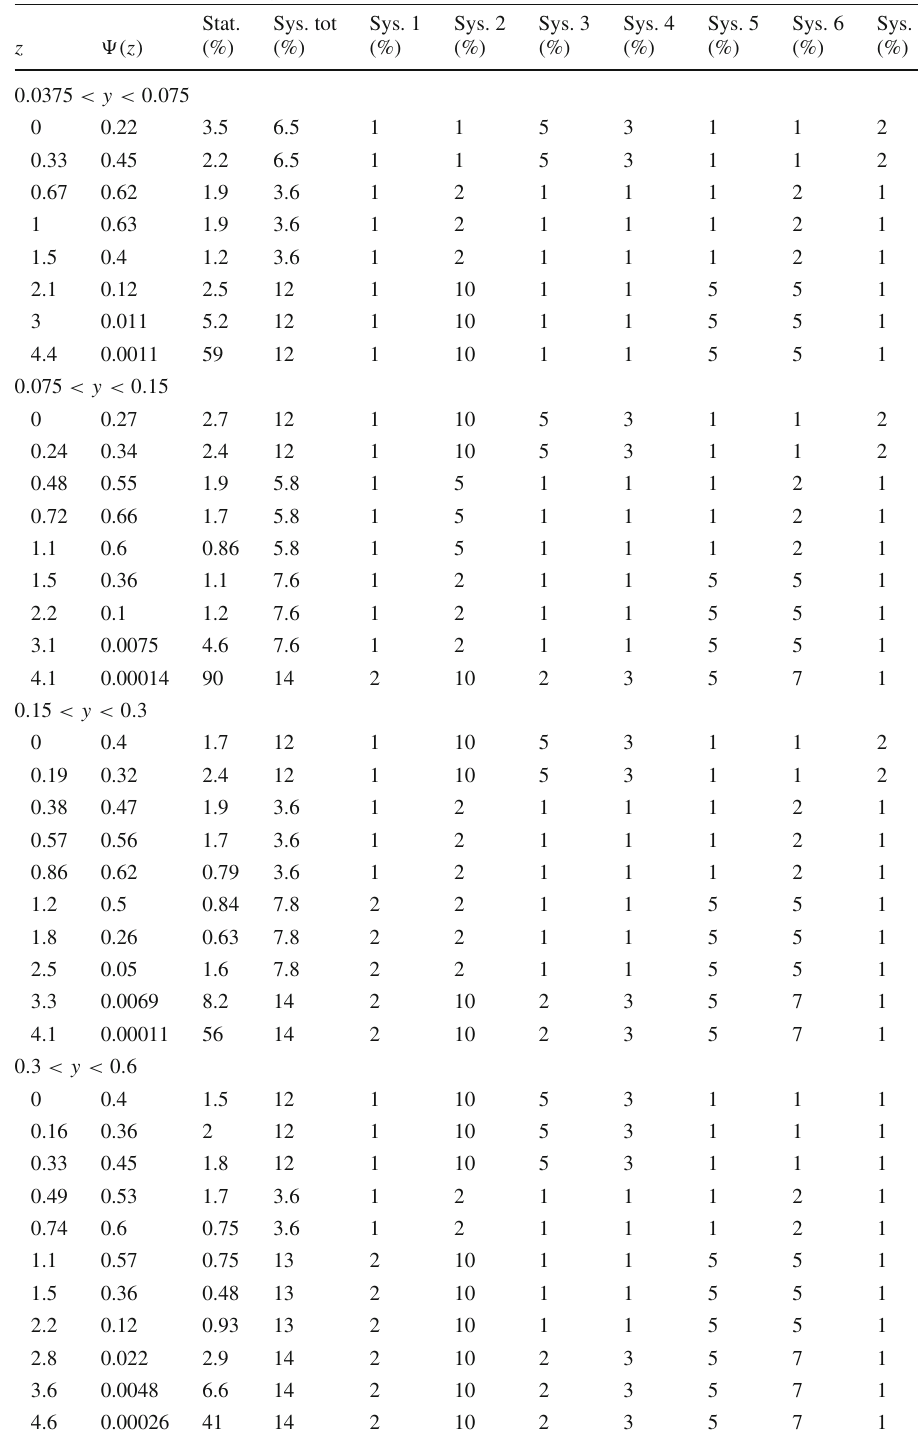
KNO function of multiplicity distributions in DIS 5 < Q 2 < 10 GeV 2 and 0 < η ∗ <